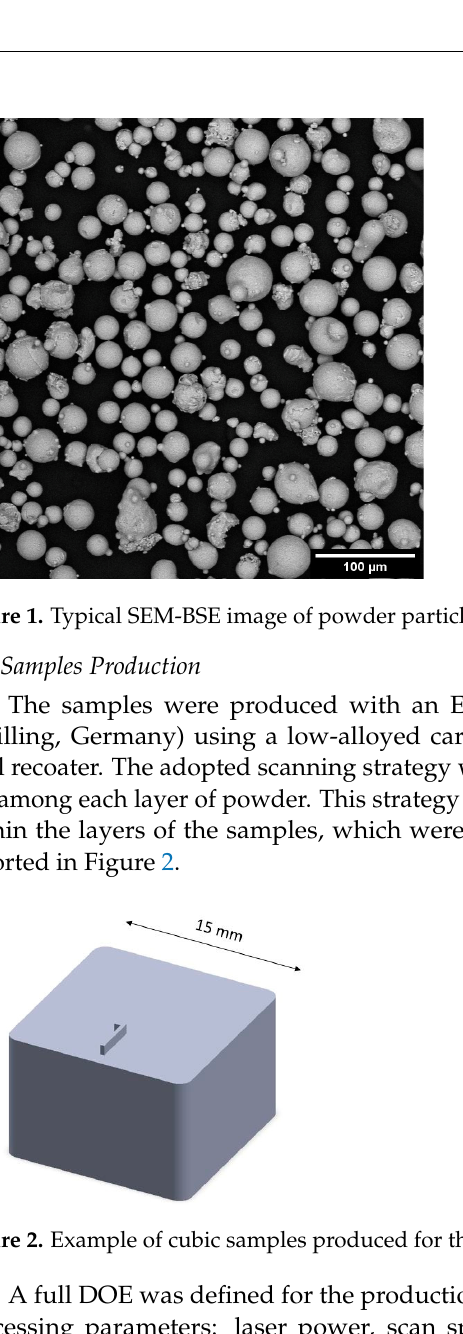
Figure 2. Example of cubic samples produced for the parameter optimization. Table 1. Process parameter ranges used in the DOE, full window Table 1. Process parameter ranges used in the DOE, full window variation.